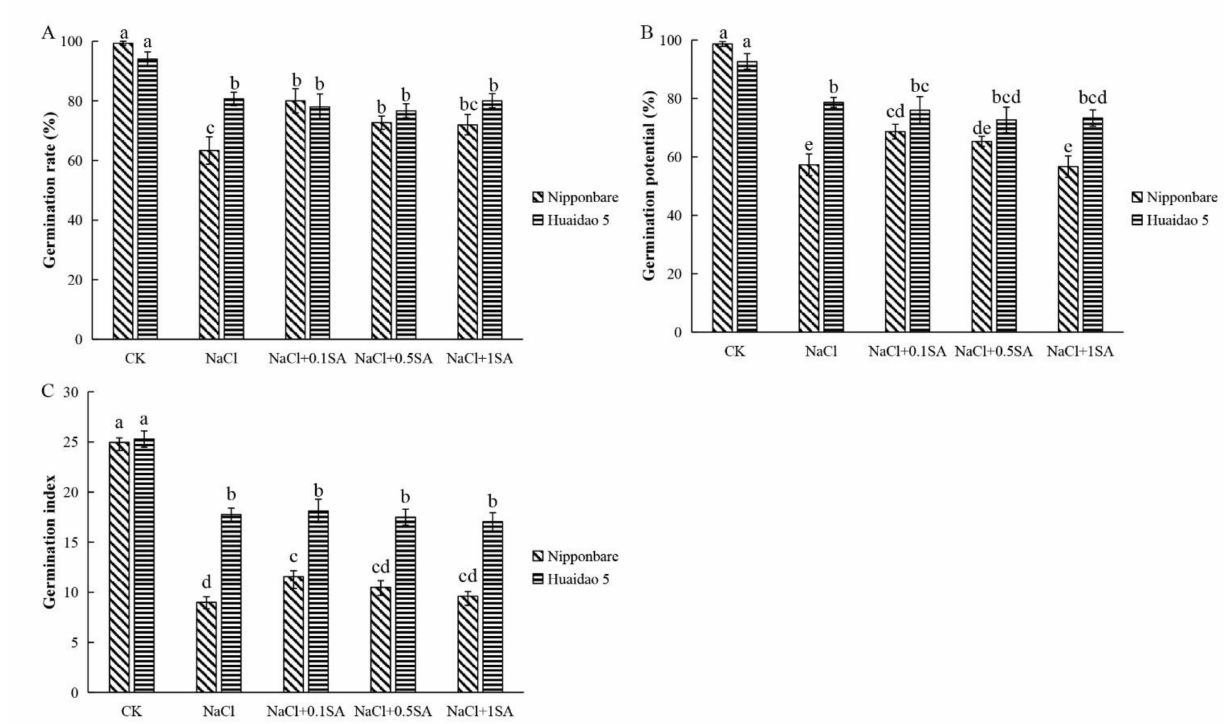
Figure 1. Effects of different concentrations of SA on the germination of rice seeds (Nipponbare and Huaidao 5) under salt stress. Distilled water was used in the CK treatment; the concentration of NaCl was 150 mM (NaCl), and the dosage of salicylic acid (SA) was 0.1, 0.5, or 1 mM (NaCl + SA). The seeds were incubated in a 90 mm culture dish with two layers of filter paper for 5 days, followed by calculation of ( A ) germination rate, ( B ) germination percentage, and ( C ) germination index. Data are presented as means ± SE. Different lowercase letters indicate significant differences between treatments ( p < 0.05).